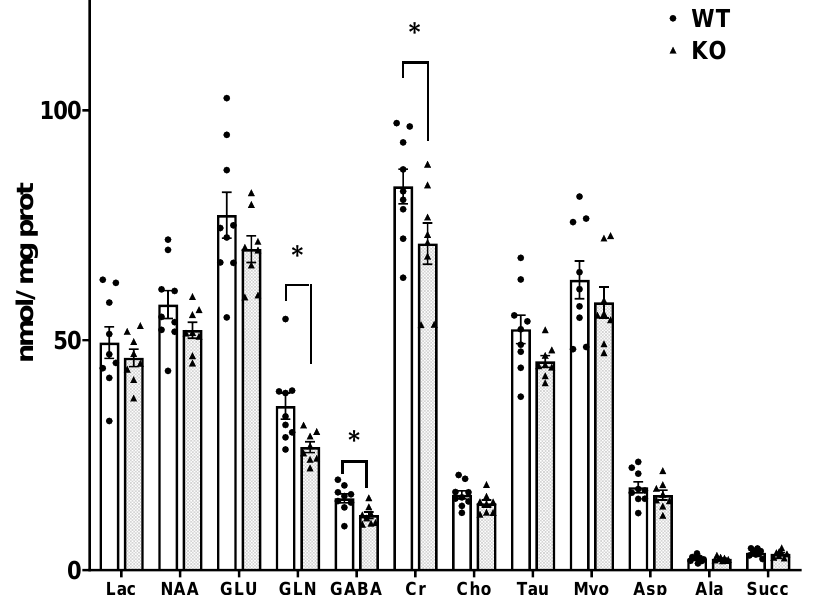
Figure 2. Concentration of metabolites in male and female brain from adult WT (white bars) and SIRT3 KO mice (gray bars). Individual data points are indicated by circles and triangles. Values for metabolites were obtained from 1 H spectra of PCA extracts; concentrations were calculated in reference to the internal standard TMSP. Values for amino acids were corrected for sideband contamination as described in methods. Data are expressed as mean ± SEM. The concentrations of glutamine and GABA were lower in brains from SIRT3 KO mice compared to WT. Data from 9 SIRT3 KO and 8 WT mice were analyzed by Student’s t -test, * p < 0.05. Abbreviations: Lac, lactate; NAA, N-acetylaspartate; GLU, glutamate; GLN, glutamine; GABA, ɣ -aminobutyric acid, Cr, total creatine; Cho, choline; Tau, taurine;